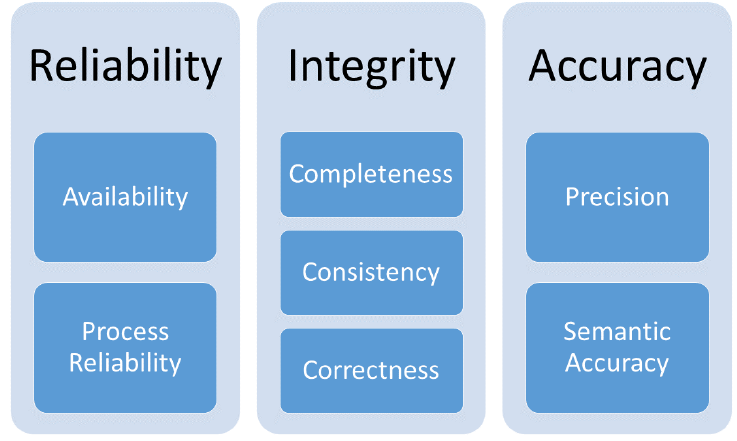
Figure 6. Quality model for 3D point clouds. Concept idea inspired by